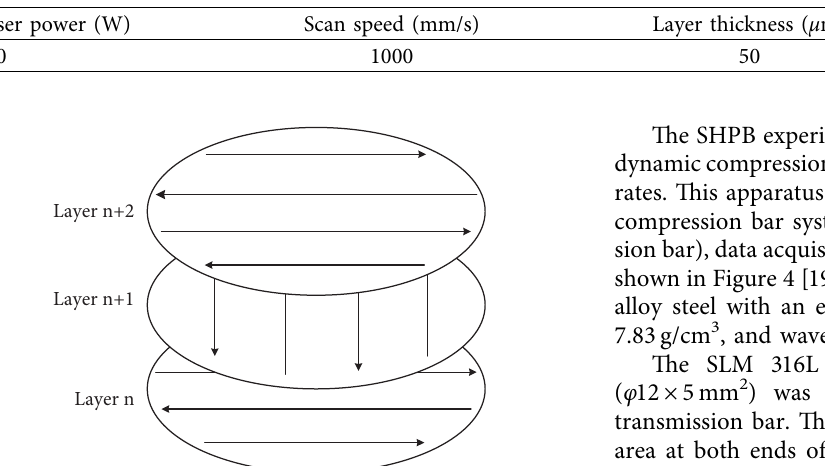
Table 2: Technology parameters of 316L stainless steel by SLM processing.